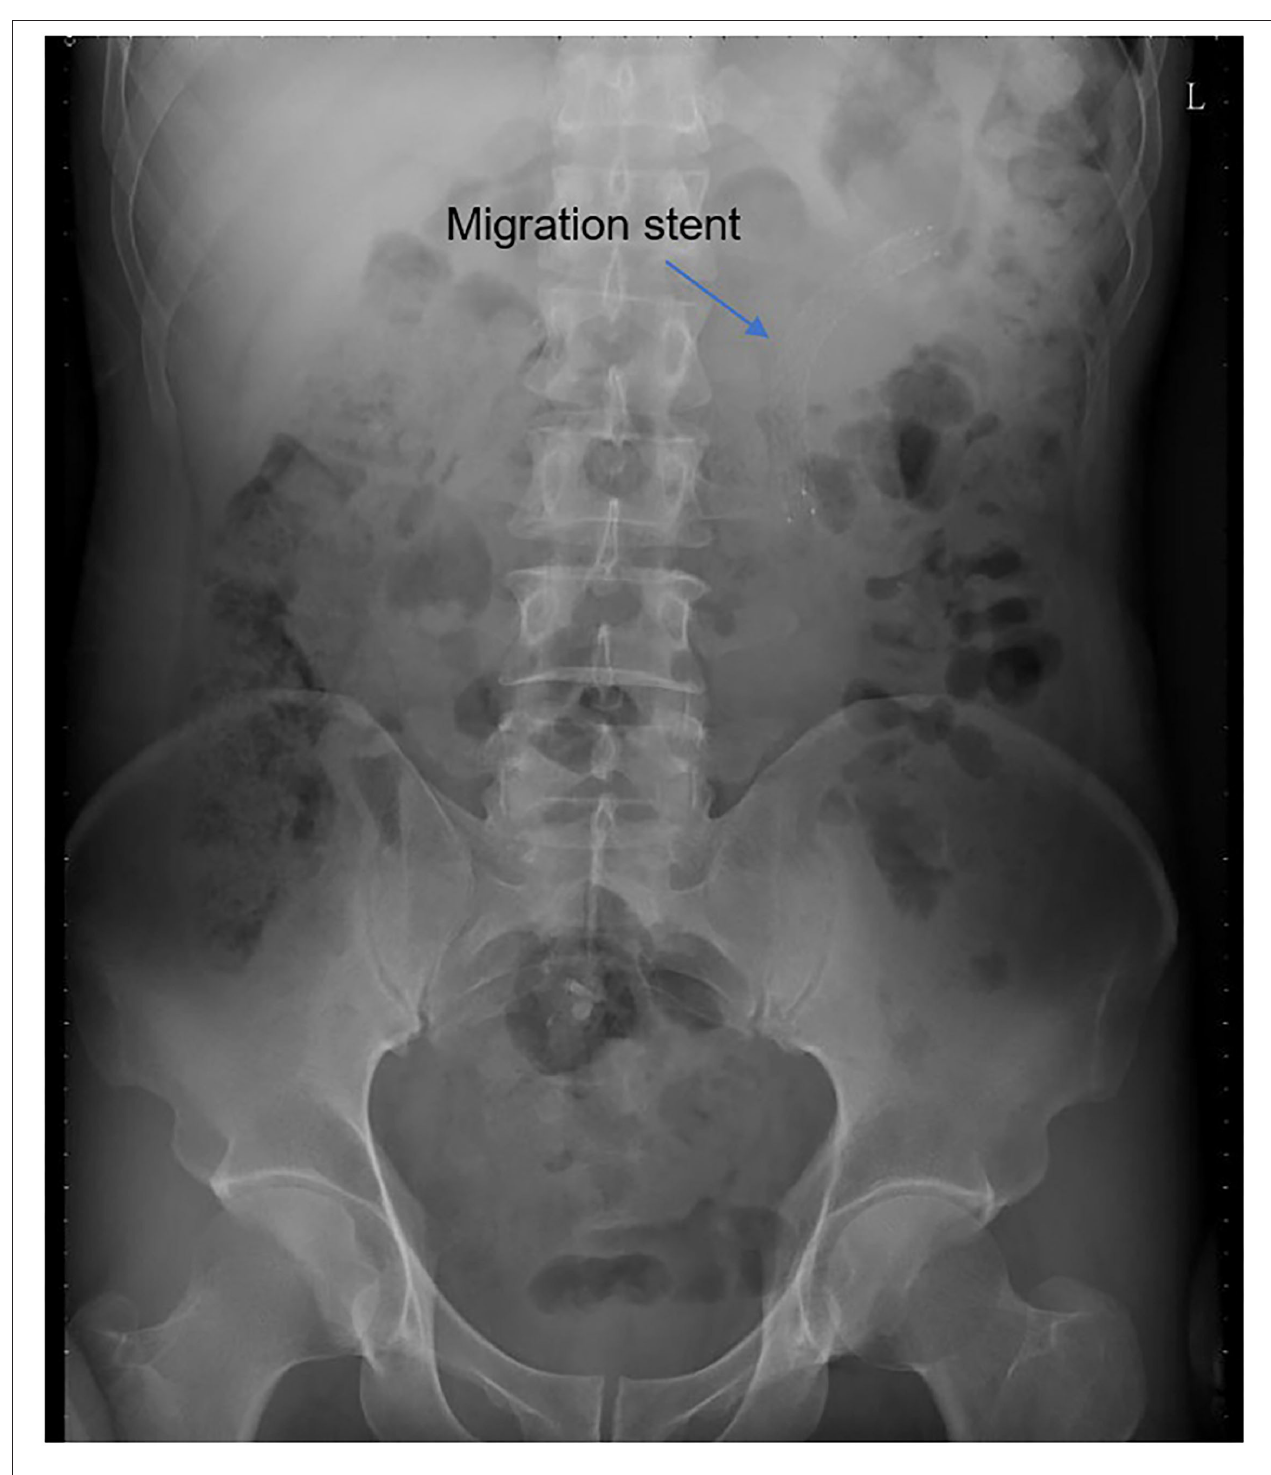
FIGURE 2 | The stent migrated to renal pelvis.